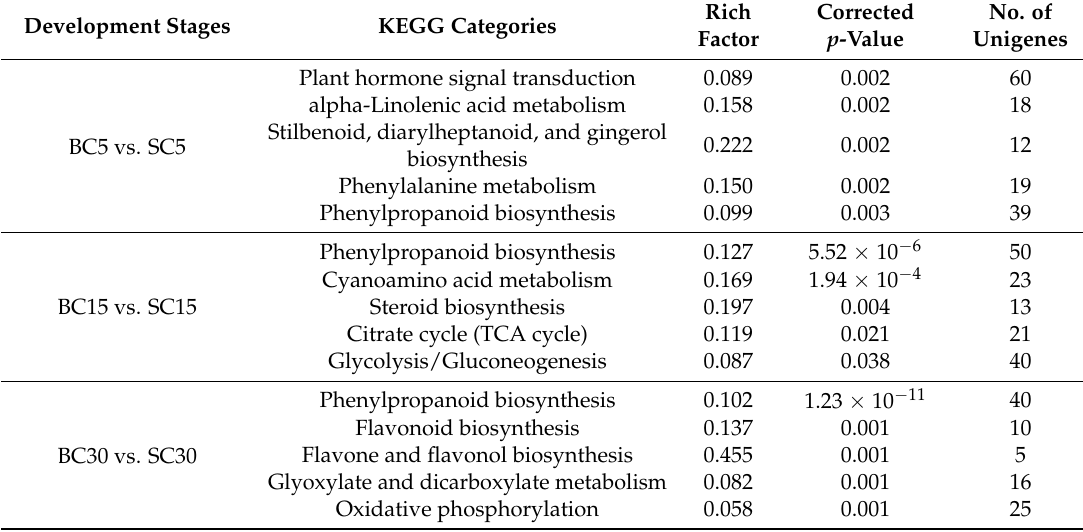
Table 3. Kyoto Encyclopaedia of Genes and Genomes (KEGG) classification of DEGs between the two types of D. sinicus at the same culm-development